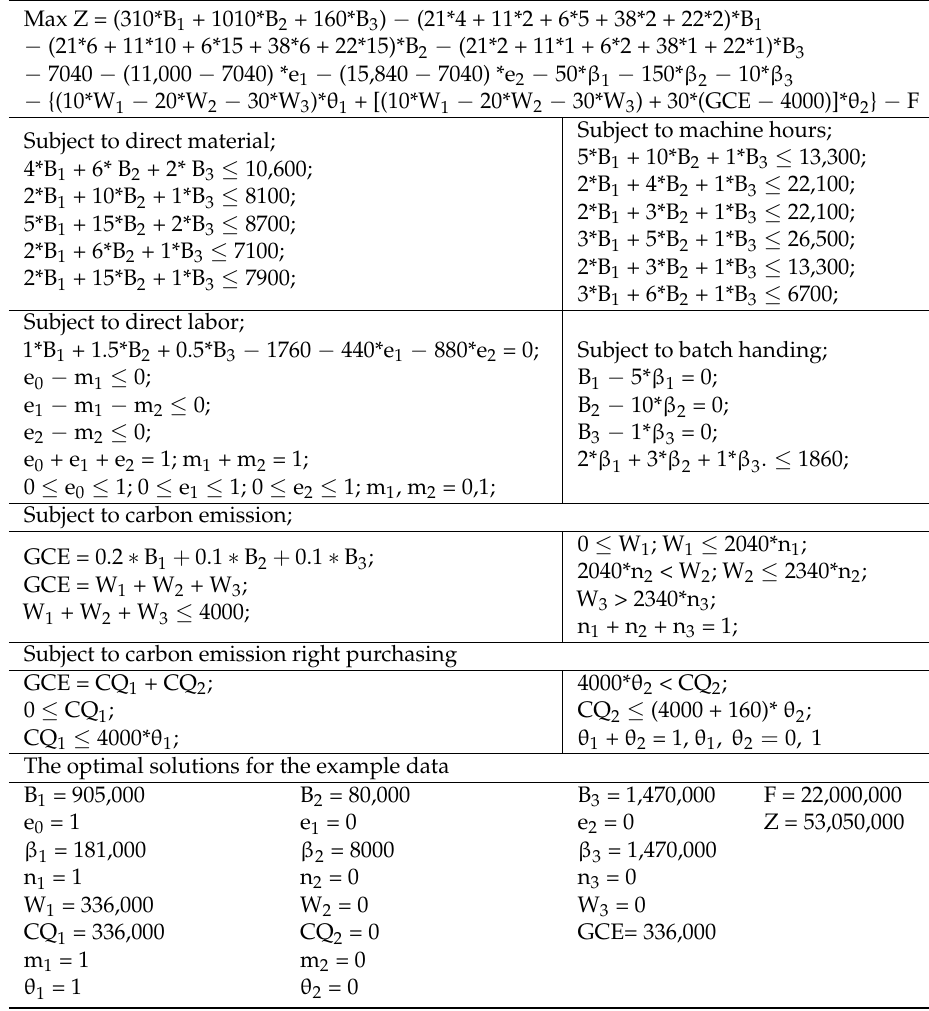
Table 3. The model and its optimal solutions with the illustrative data for Model